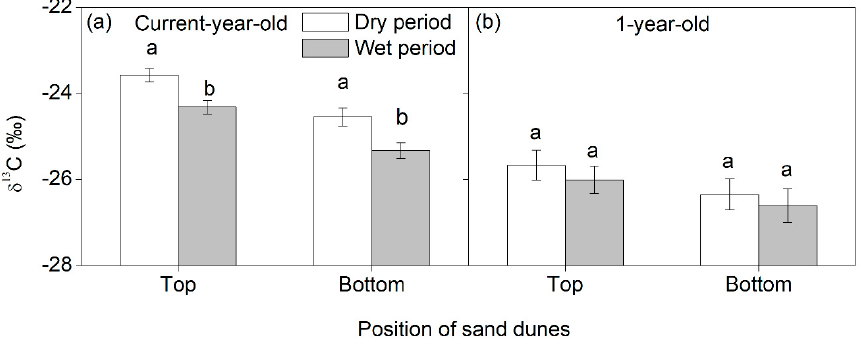
Figure 6. Needle δ 13 C of the current- and 1-year-old ( a and b ) during the dry and wet periods for Mongolian pine trees growing on the top and bottom of the sand dunes. Error bars represent standard deviation ( n = 4). Different letters indicate significant differences between dry and wet periods on the same topographic position.